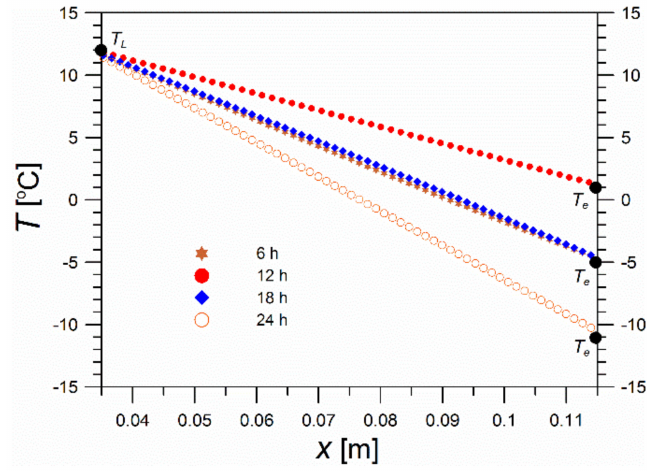
Figure 8. Temperature profiles in the insulation layer. In Figure 9a, the effect of the ambient temperature, T e , on the temperature of the ATI layer, T f , and the heat flux supplied in this layer, q f , is depicted. The process under both steady and transient conditions was considered. In the first case, the temperature T e is assumed to be invariable throughout the day, T e = T em . In this case, the temperature T f and the heat flux q f are also invariant and equal to T f = 11.67 ◦ C and q f = 5.18 W/m 2 .